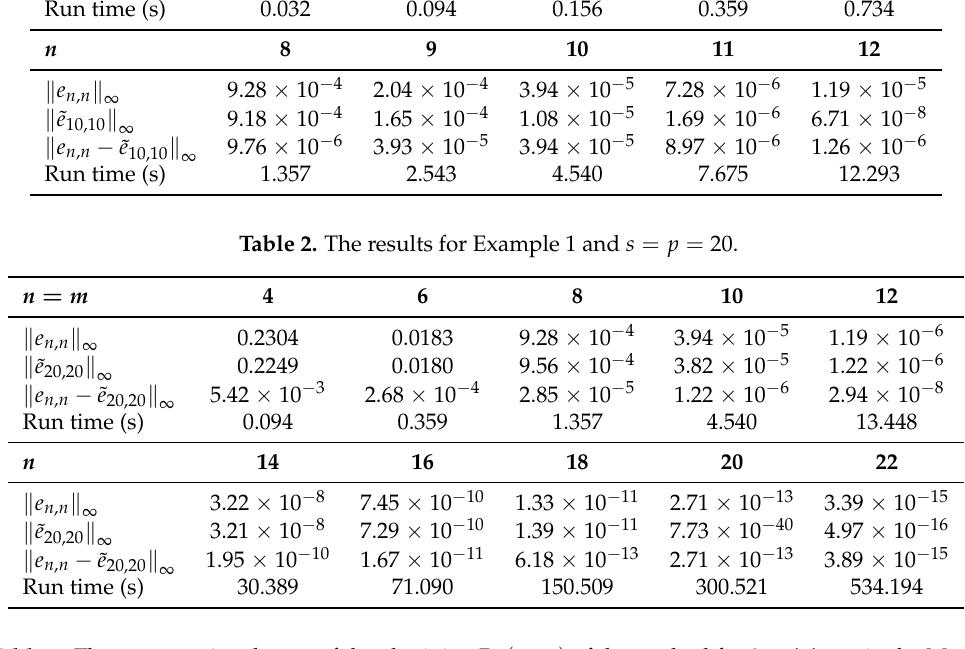
Table 3. The computational costs of the obtaining Re ( x i , t j ) of the method for 0 ≤ i , j ≤ n in the Maple code for Example 1.